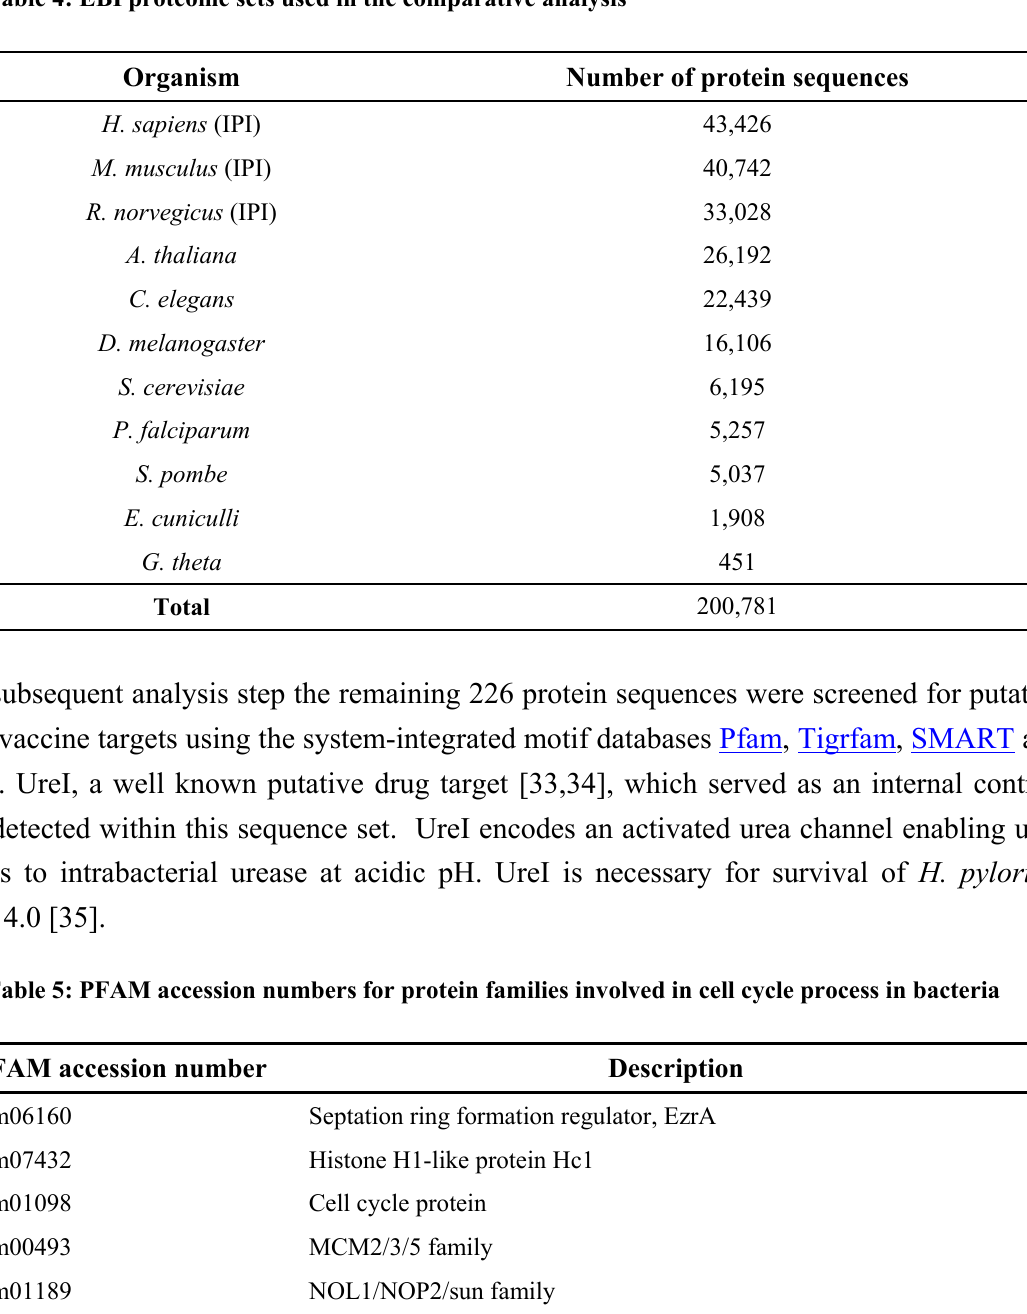
Table 4: EBI proteome sets used in the comparative analysis